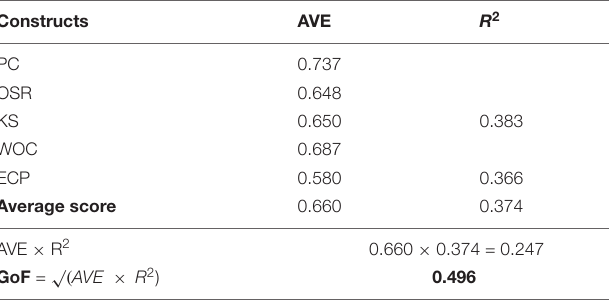
TABLE 5 | Goodness of